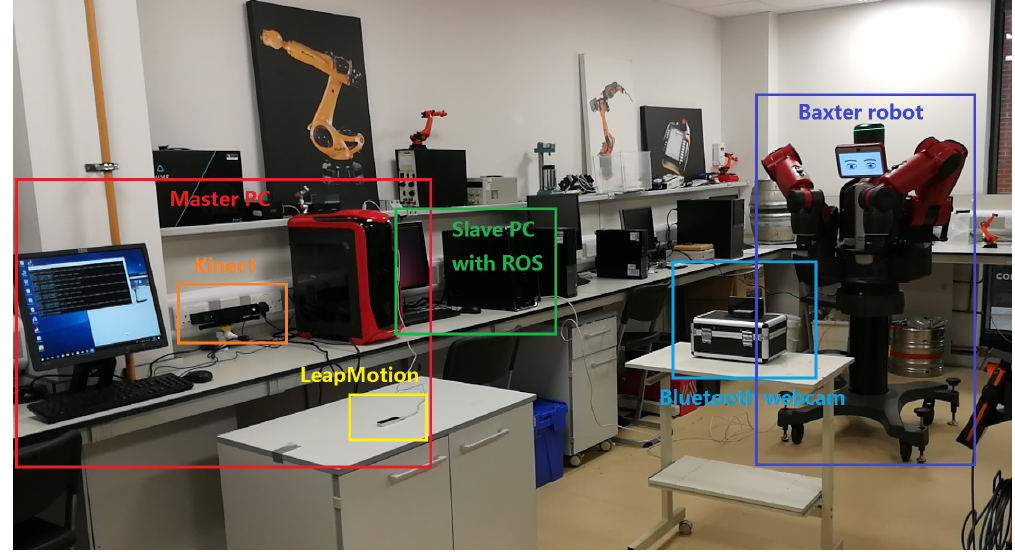
Figure 8. The experimental human robot interaction